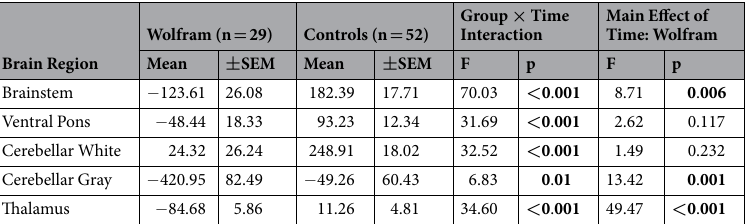
indicate that within controls, as expected based on the literature, volumes increased across most major white mat- ter regions, including brainstem and cerebellar white matter, whereas cortical gray matter volume decreased over time, particularly within the precuneus/cuneus and prefrontal cortex (Fig. 2c). In contrast, within the Wolfram group, white matter volumes did not show any increase over time. In addition, the ventral pons region of the brainstem and cerebellar white matter actually decreased in volume over time (Fig. 2d). Thalamus and cerebellar gray matter volume decreased in Wolfram over time, but was stable in controls. Regions of interest (ROI) results. Based on the voxel-wise group by time findings, we selected brainstem, ventral pons, thalamus, cerebellar gray and cerebellar white matter regions. As expected, these regions all had significant interactions between group and time (p < 0.01; Table 2) and none had any group by time by age interactions, recapitulating the patterns observed in the voxel-wise analyses. In brainstem, ventral pons and cerebellar white matter, controls tend to increase in volume over time and age and the Wolfram group tend to decrease in volume over time and age (Fig. 3a–c). In the thalamus, we observed a striking decrease in volume in the Wolfram group over time while controls remained stable (Fig. 3e). Cerebellar gray matter decreased in both groups, but was more accentuated in the Wolfram group (Fig. 3d).